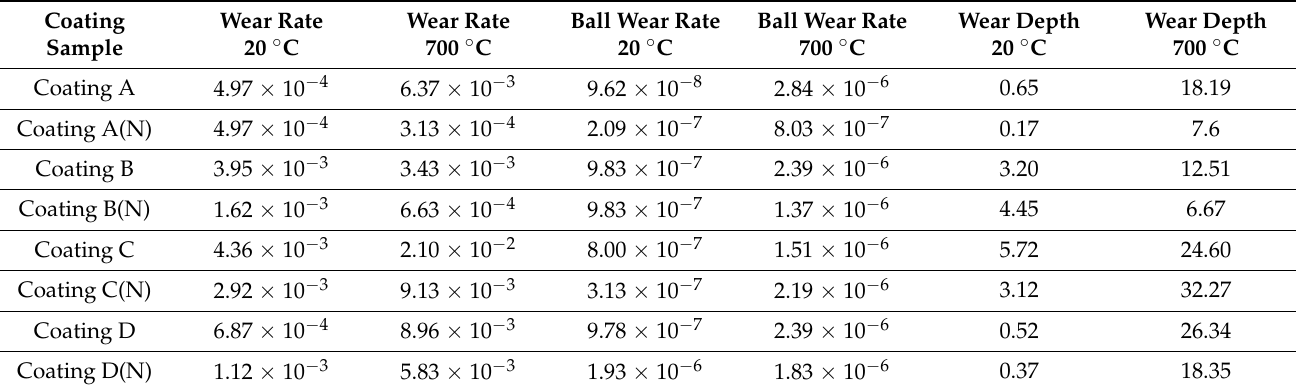
Table 4. Wear rate and wear depth of